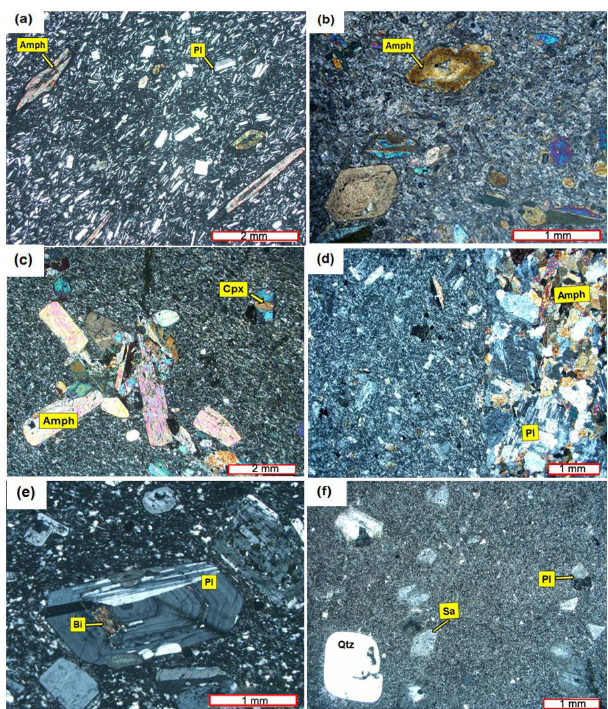
Figure 4. Representative photomicrographs (XPL). (a) Flow texture and presence of acicular amphiboles and plagioclases in andesite. (b) Euhedral to subhedral amphiboles with compositional zoning in trachyandesite. (c) Photomicrograph of amphibole and clinopyrox- ene phenocrysts in a fine-grain matrix in andesite. (d) Photomicro- graph showing contact between crystal clot containing plagioclase and amphibole and host trachyandesite rock. (e) Zoned plagioclase phenocryst in decite. (f) Embayment and rounded quartz, altered sanidine and plagioclase in rhyolite.